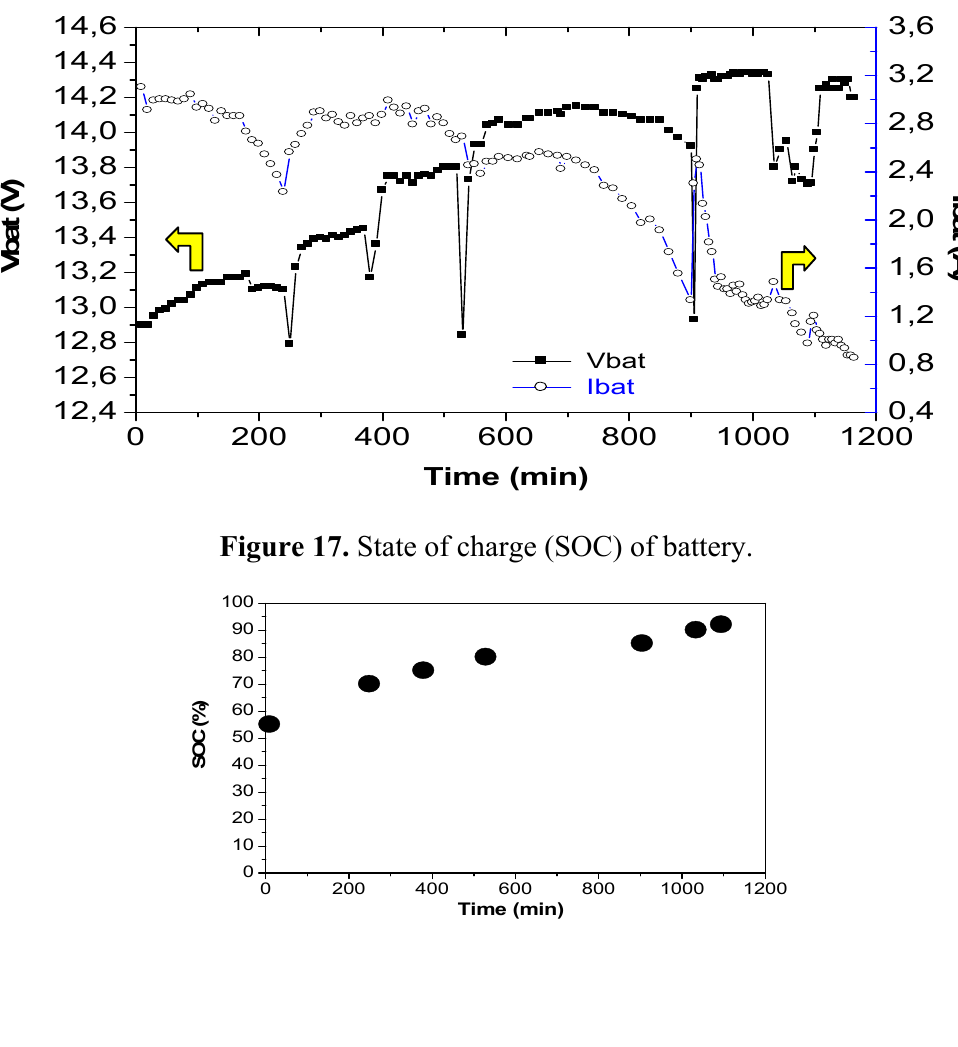
Figure 16. Current and voltage of charge of the battery (12 V, 110 Ah).